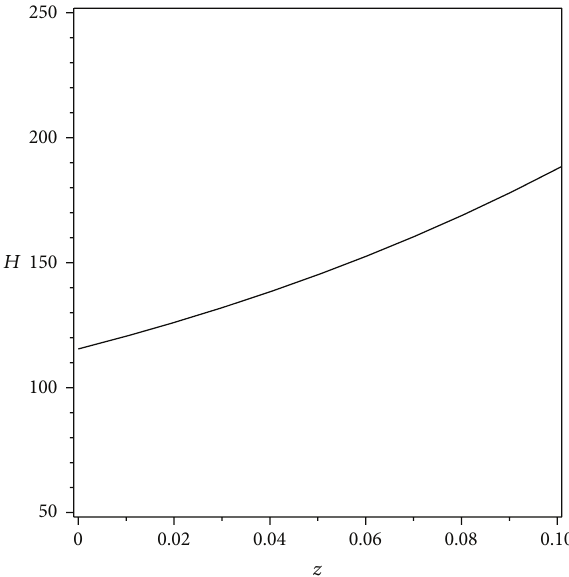
Figure 4: Hubble expansion parameter versus redshift in case of 𝑛 = 2 , for 𝐴 = 1/3 , and 𝛼 = 0.5 for 𝐶 = 1